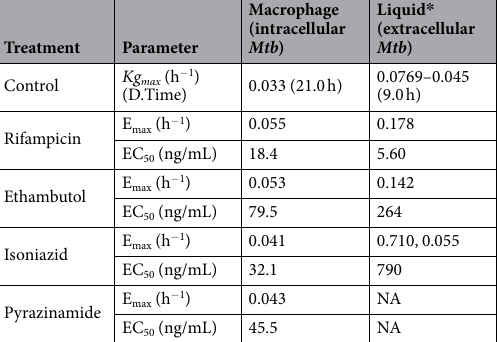
Table 1. Comparison of growth and pharmacodynamic killing kinetics for planktonic (extracellular liquid culture) and intracellular (macrophage) M. tuberculosis . Kg max represents the maximal growth rate, E max represents the maximal possible kill rate and EC 50 the concentration required to achieve 50% of the E max rate of kill. Parameters were derived from data generated from multiple independent experiments (n ≥ 3) performed in triplicate. NA, Not applicable. * For comparison, extracellular PD parameters based on in house and published values 24, 25